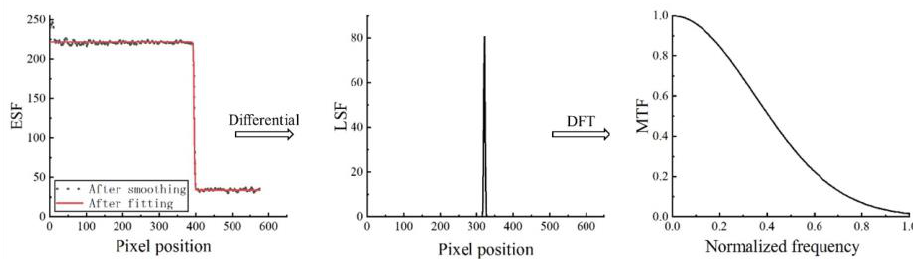
Figure 7. MTF Calculation Process.